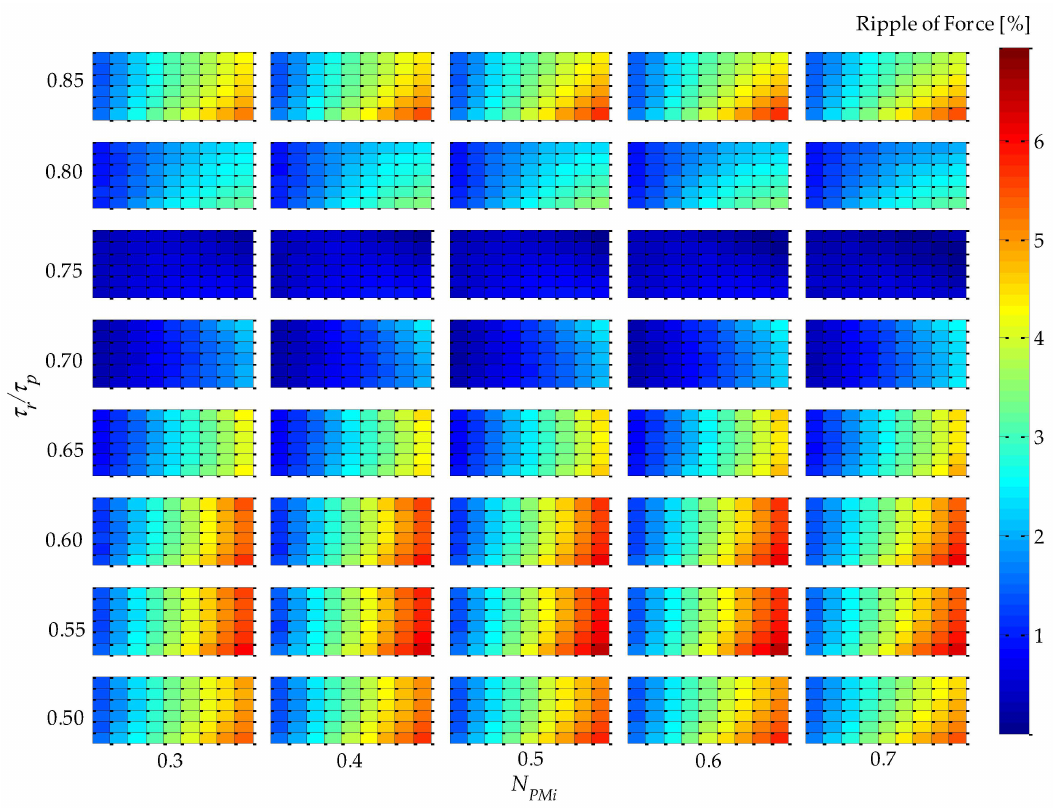
Figure 14. Results of absolute percentage static force ripple of the coupled design for four parametric variables: τ r / τ p , N PMi , N CPMs , and n form